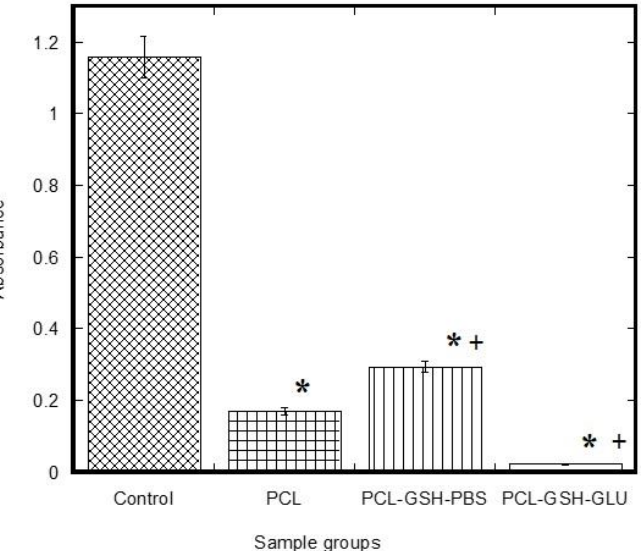
Figure 9. Cytotoxicity test result for PCL-GSH-GLU, PCL-GSH-PBS, PCL only and control (n = 4). In the figure, * refers p < 0.05 compared to control Absorbance of LDH value and + refers p < 0.05 compared to PCL Absorbance of LDH value.